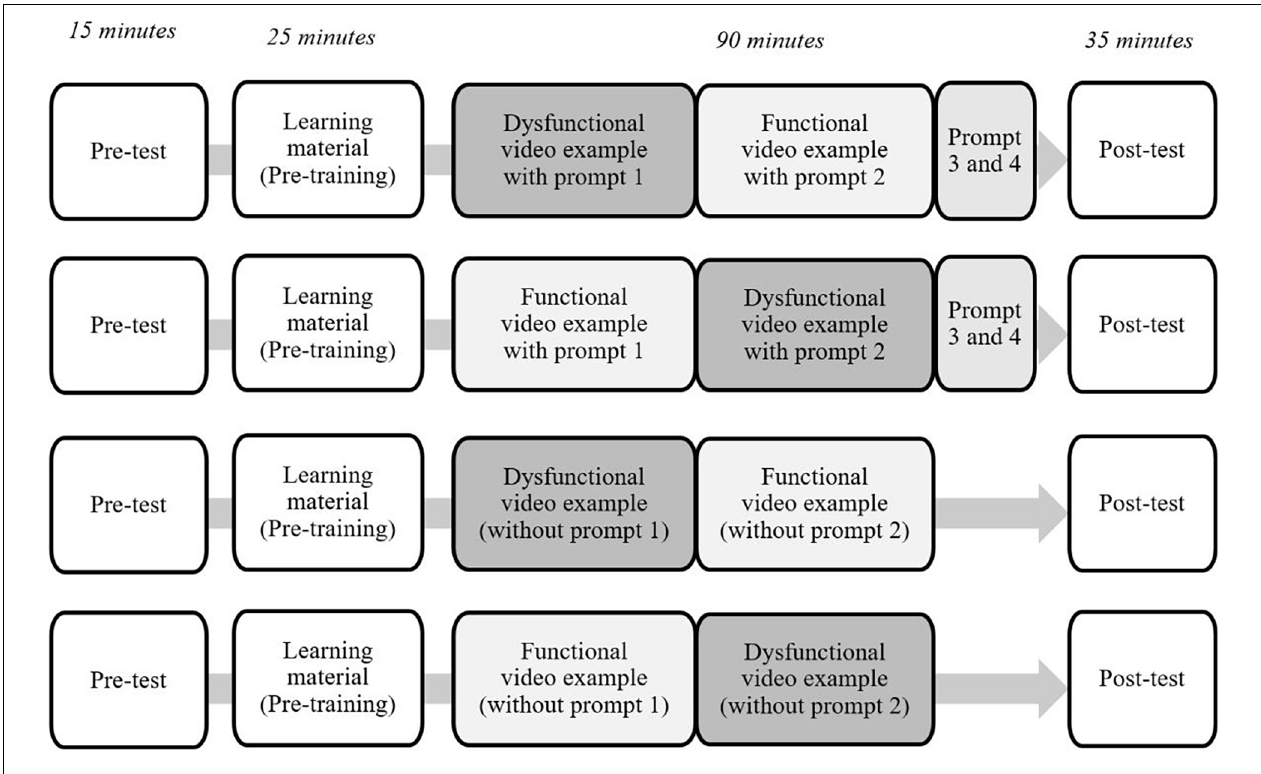
FIGURE 2 | Procedure for the four experimental groups (df+; fd+; df − ; fd − ). TABLE 2 | Means and standard deviations for all variables, depending on the experimental